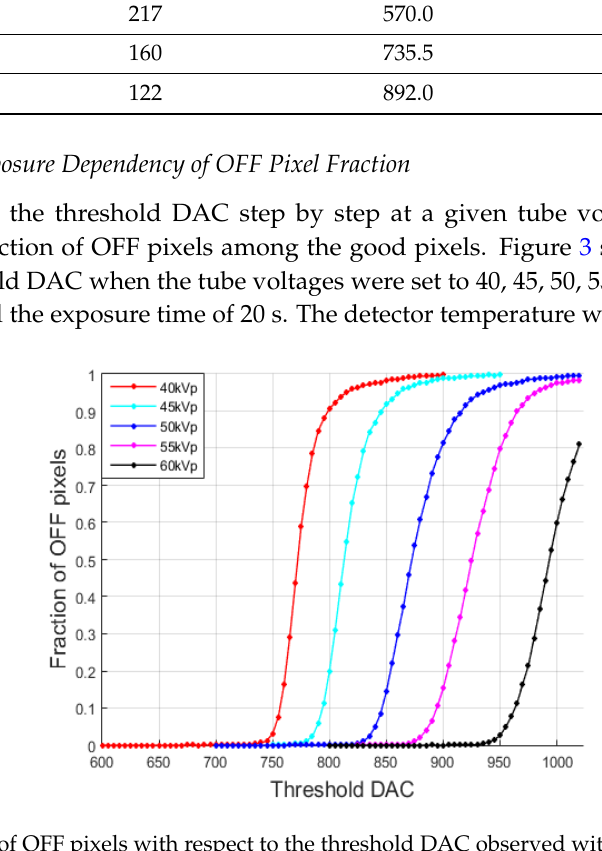
Figure 3. Fraction of OFF pixels with respect to the threshold DAC observed with the tube